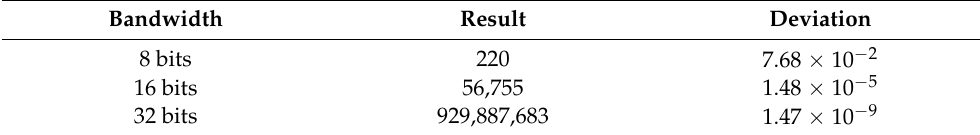
Table 3. Comparison of different bandwidth 0.524 rad cosine value generated by the RT technique.